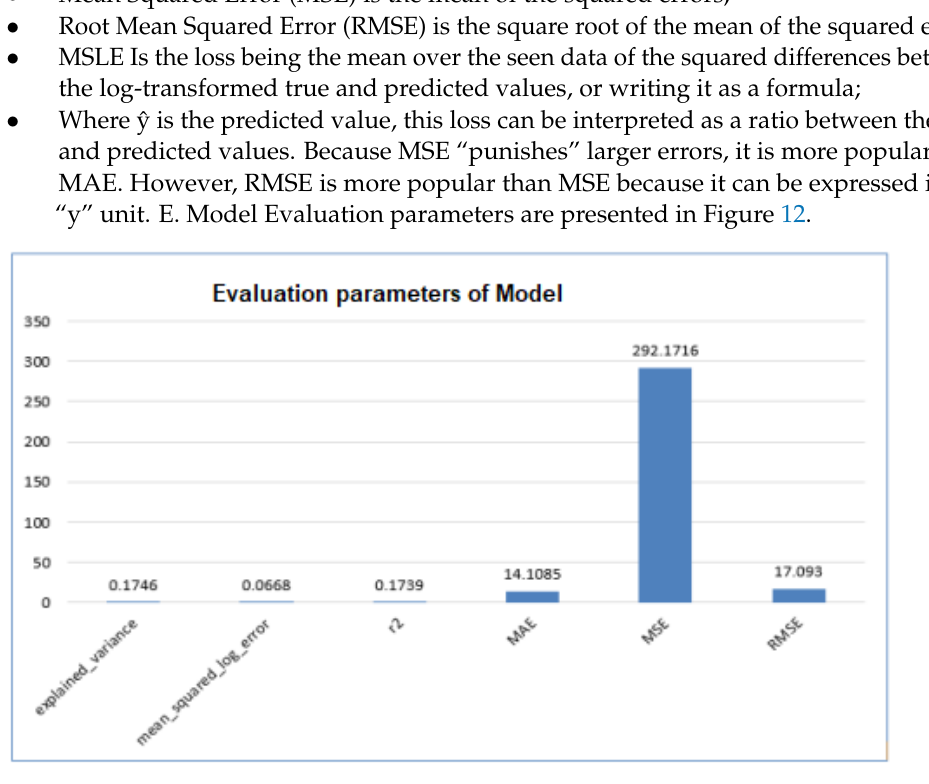
Figure 12 . Model Evaluation parameters. Figure 12. Model Evaluation parameters.